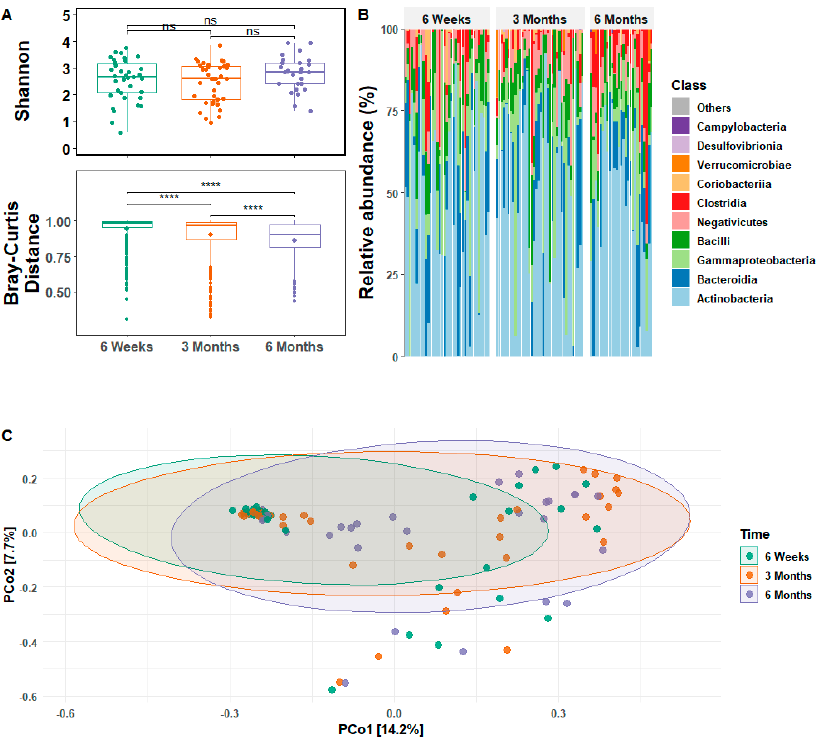
Figure 1. Relative abundance and diversity of infant gut microbiota across three ages. ( A ). Microbial alpha diversity, calculated as Shannon’s richness, is plotted in the top row, and beta diversity, calculated as Bray-Curtis Distance, is plotted in the bottom row. Both measures are indicated for all three ages. **** indicates p < 0.0001, ‘ns’ indicates no significance. ( B ). Relative abundance (%) is shown on the left, and each individual is depicted as a vertical bar grouped by age. The top 10 microbial classes are coded by color, with the least abundant class indicated at the top of each bar. Remaining classes are grouped together and labeled as “others” in gray. ( C ). Principal coordinate analysis (PCoA) of Bray-Curtis distances between the three ages. Circles represent 95% confidence ellipses. The relative sizes of the x and y axes are normalized, so they represent the same amount of variation for the first two PC axes to more faithfully represent the distances between samples, i.e., the x axis is roughly twice the length of the y axis.